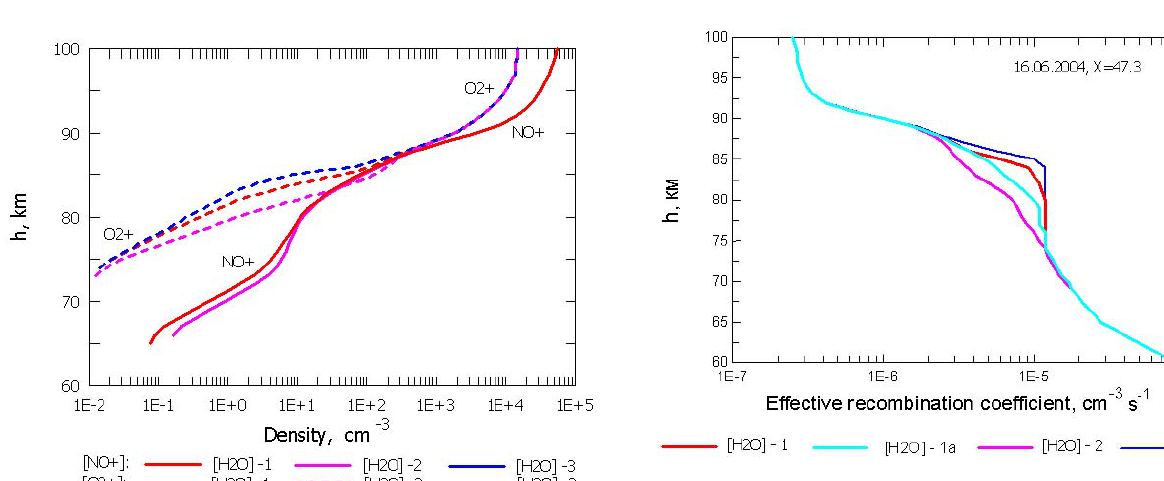
Fig. 6b. Effective recombination coefficient profiles for 16 June 2004 at 12:00UT, with a solar zenith angle of 47.3 ◦ Fig. 5c. Number density profiles for the O + and NO + molecular 2 and calculated for the H 2 O-1, H 2 O-1a, H 2 O-2 and H 2 O-3 profiles ions for 16 June 2004 at 12:00UT, with a solar zenith angle of 47.3 ◦ presented in Fig. and calculated for the H 2 O-1, H 2 O-2 and H 2 O-3 profiles.